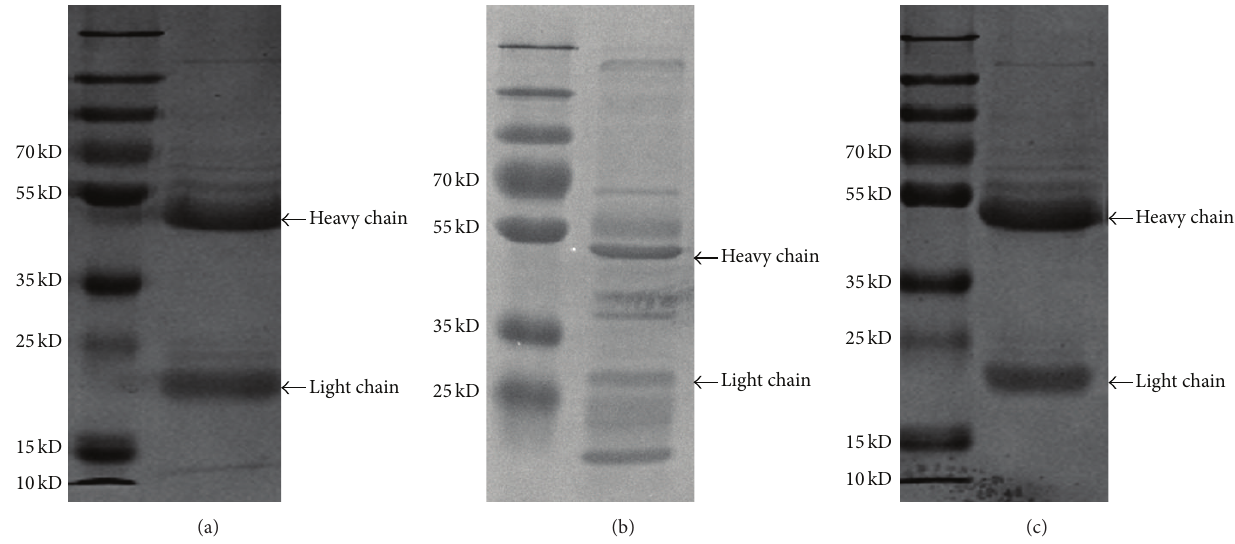
Figure 2: Purity of AT1-mAb from hybridoma supernatant and mouse ascites. (a) IgG control; (b) the antibody extracted from hybridoma supernatant; (c) the antibody extracted from mouse ascites.